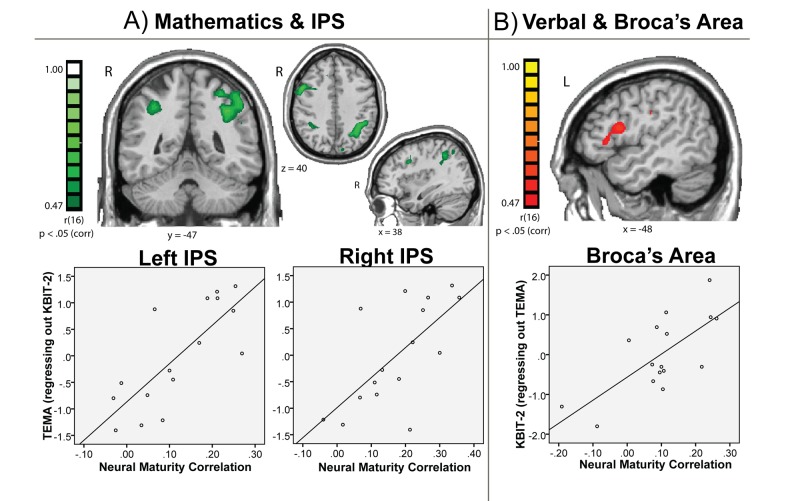
Whole-brain correlation of natural viewing neural maturity and test scores.(A) Children's intersubject correlation to adults in the IPS bilaterally predicts their performance on a mathematics IQ test (TEMA), independently of their KBIT IQ test performance (whole brain analysis, cluster corrected at p<0.05, minimum 88 voxels). The figure shows regions that emerged from the whole brain correlation (top) and the mean correlation across the left and right IPS clusters (bottom). (B) Children's neural maturity in the left inferior frontal gyrus (Broca's area) predicts their performance on the KBIT verbal IQ test after regressing out their mathematics performance (TEMA). The top panel shows the results of the whole brain analysis (whole brain analysis, cluster corrected at p<0.05, minimum 65 voxels). The bottom panel shows the mean correlation across the Broca's area cluster to illustrate individual subject data.